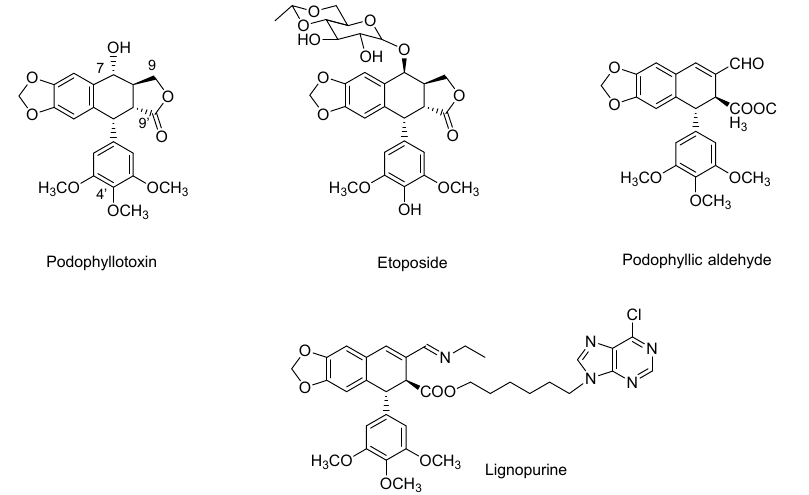
Figure 1. Chemical structures of natural product podophyllotoxin, clinically approved derivative etoposide, non-lactonic cyclolignan podophyllic aldehyde and lignopurine, a hybrid with a purine moiety.